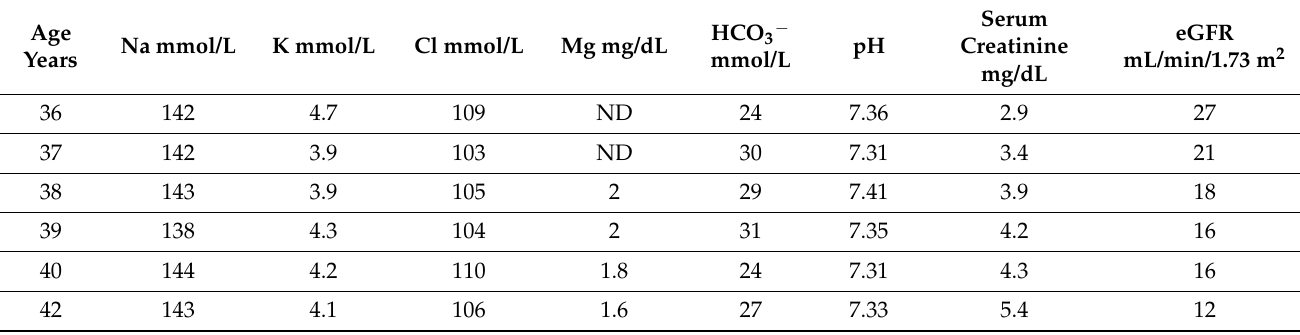
(Table 1). Several intents of treatment with a low dose of Telmisartan (10 mg/daily) resulted in hypotension and were discontinued. Table 1. Evolution of electrolytes and renal function on the